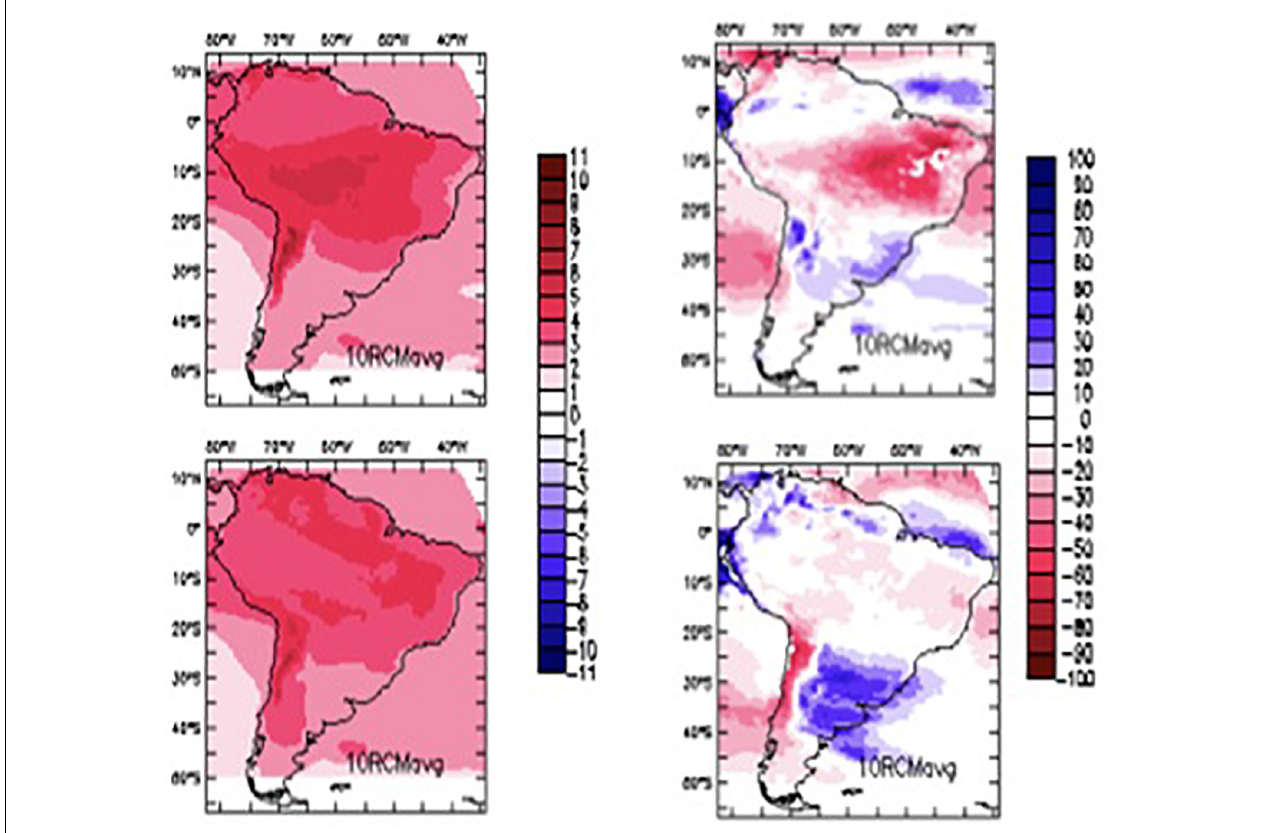
FIGURE 10 | Projections of seasonal mean temperature (left; in ◦ C) and seasonal mean precipitation (right; in%) for the period 2071–2100, according to an ensemble of RCMs for the SRES A1B scenario for JJA (top) and DJF (bottom). Adapted from Sánchez et al.